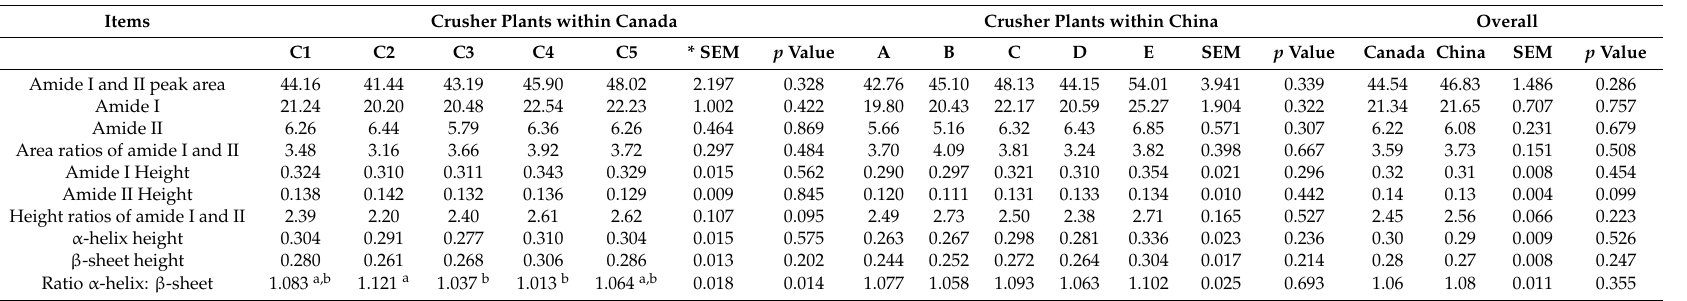
Table 5. Protein molecular structure characteristics of oil-seeds from bio-oil processing (canola seeds): Comparison of crusher plants within Canada and within China as well as between Canada and